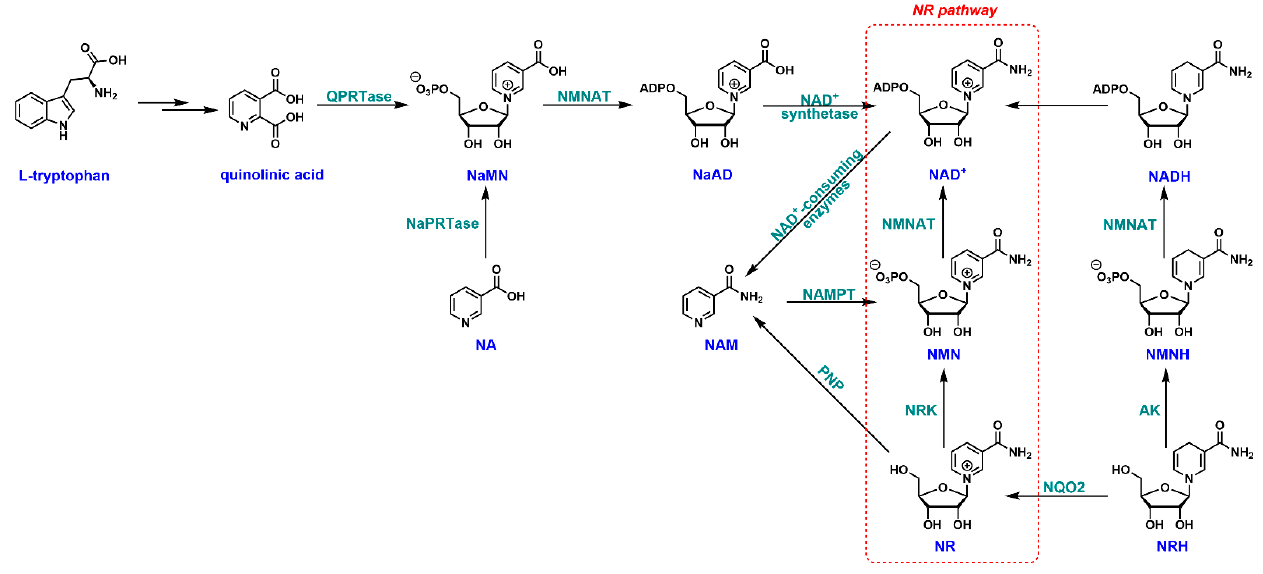
Figure 1. NAD + biosynthetic pathways in mammalian cells. NA: nicotinic acid; NAM: nicotinamide; NR: nicotinamide riboside; NMN: nicotinamide mononucleotide; NaMN: nicotinic acid mononucleotide; NaAD: nicotinic acid adenine dinucleotide; NRH: reduced nicotinamide riboside; NMNH: reduced nicotinamide mononucleotide; QPRTase: quinolinate phosphoribosyltransferase; NMNAT: nicotinamide mononucelotide adenylyltransferase; NaPRTase: nicotinic acid phosphoribosyl transferase; NAMPT: nicotinamide phosphoribosyl transferase; NRK: nicotinamide riboside kinase; PNP: purine nucleoside phosphorylase; AK: adenosine kinase; NQO2: NRH: quinone oxidoreductase 2.